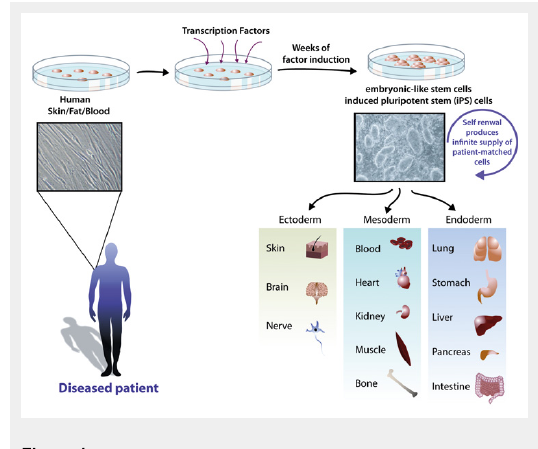
Reprogramming human patient samples can generate patient- specific human induced pluripotent stem (iPS) cells. iPS cells share extensive defining characteristics with embryonic stem